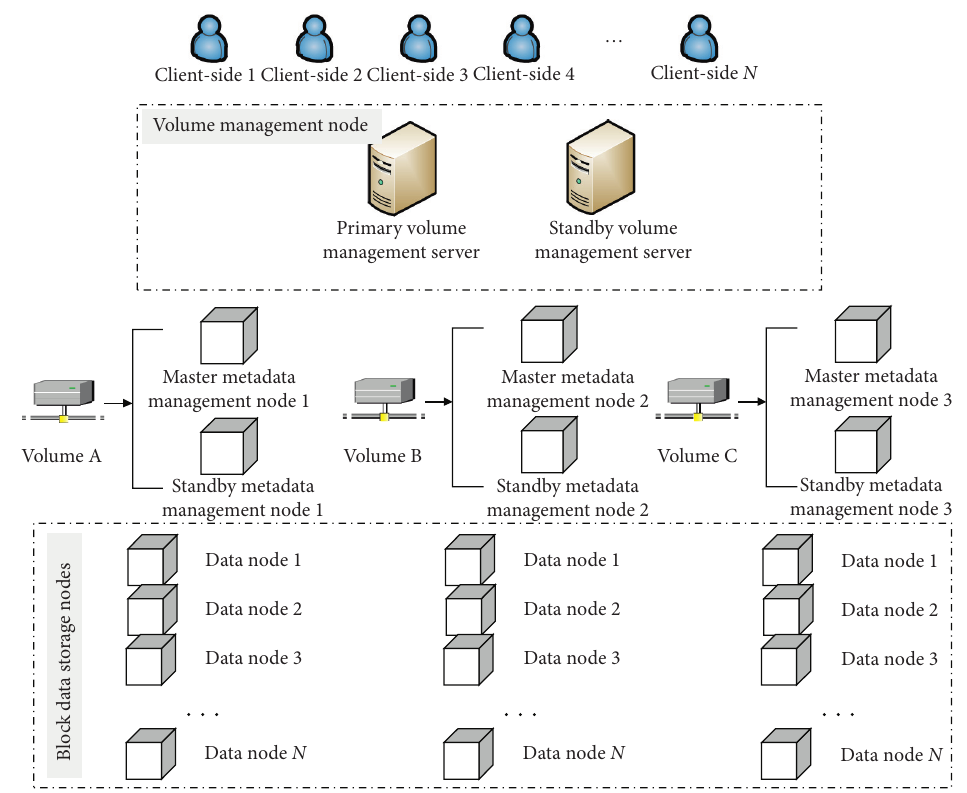
Figure 3: The organizational structure of the data storage